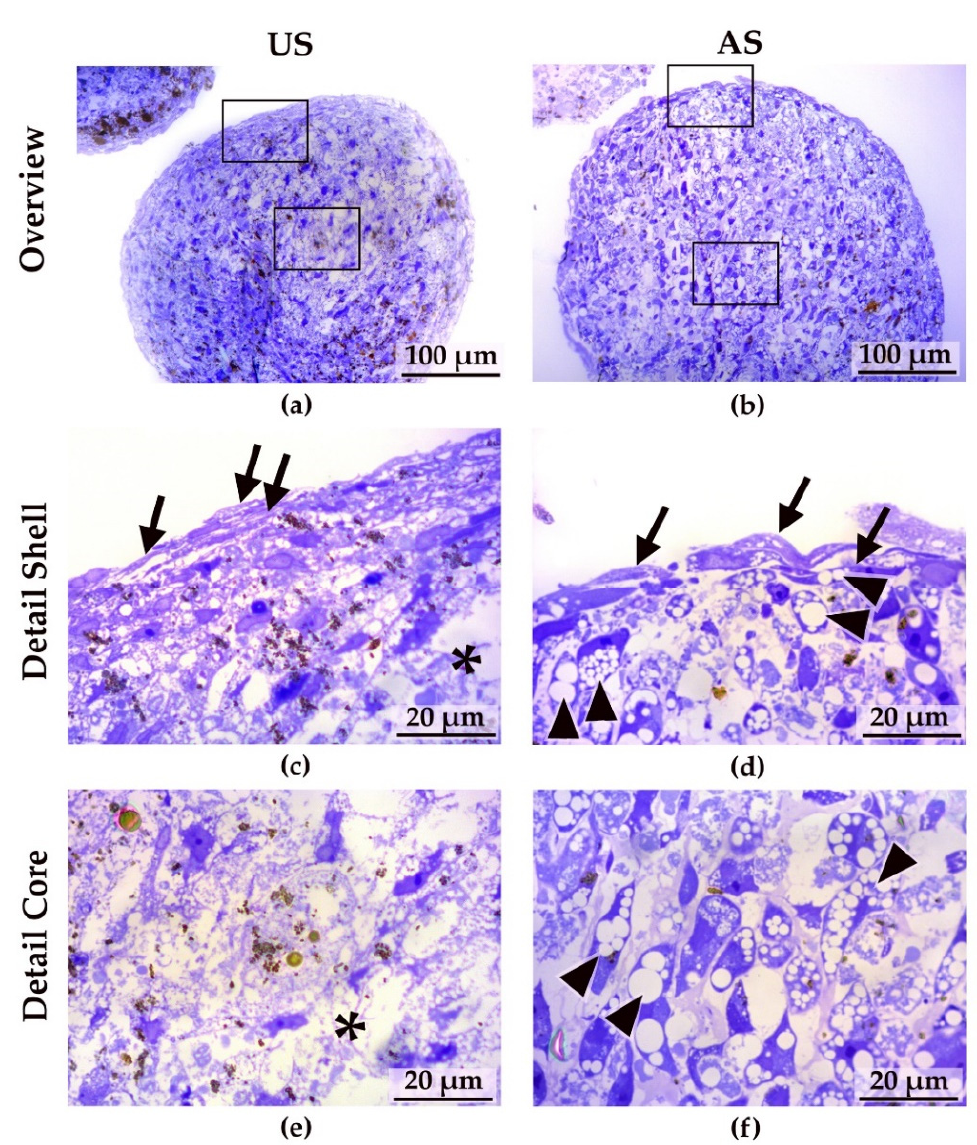
Figure 4. Thin sections (0.5 µ m) of unstimulated and adipogenically stimulated 3D spheroids after 14 days. Overview images of ( a ) an unstimulated (US) spheroid and ( b ) an adipogenically (AS) stimulated spheroid (scale bars: 100 µ m, frames in the overview images correspond to the areas shown below in high magnification, ( c ) detail of the shell region of an unstimulated spheroid (arrows: enveloping cells, asterisks: cell debris), ( d ) detail of the shell region of an adipogenically stimulated spheroid (arrows: enveloping cells, arrowheads, vacuoles), ( e ) detail of the core of an unstimulated spheroid (asterisks: cell debris), ( f ) detail of the core region of an adipogenically stimulated spheroid (arrowheads: different sized vacuoles; scale bars: 20 µ m; representative images of 3 experiments; light microscopy (Zeiss Axioskop 40), toluidine blue staining).